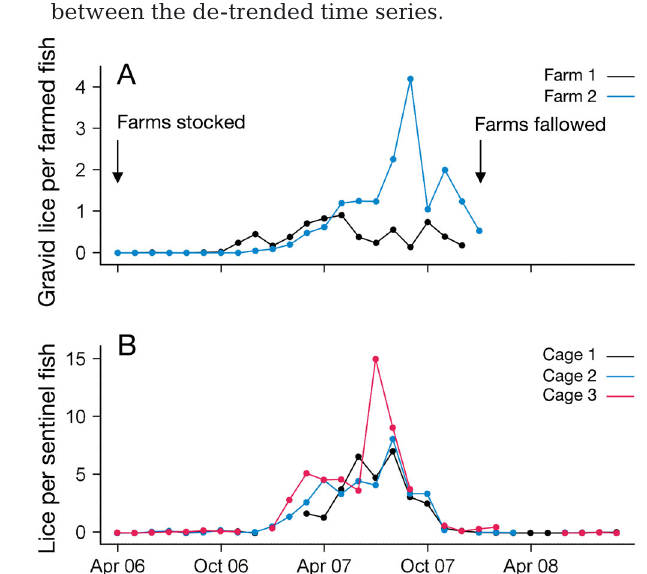
Fig. 3. Summary of sea lice counts from April 2006 to Sep- tember 2008. (A) Mean number of gravid lice on each farmed fish by farm and month, and (B) mean number of lice (all stages) on each sentinel fish by cage and month